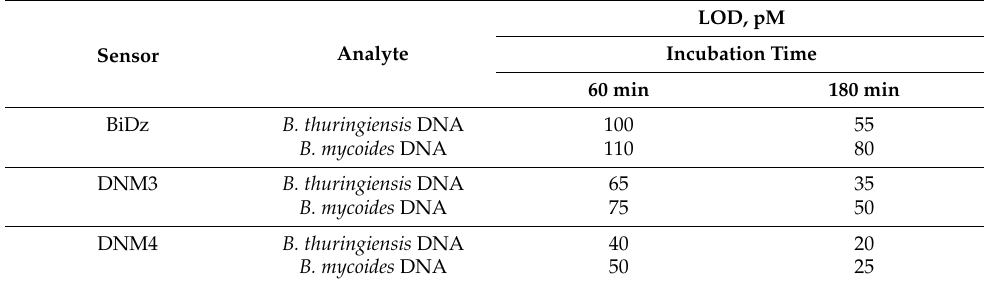
Table 2. Limit of detection for all the DNA nanosensors for the synthetic analyte.